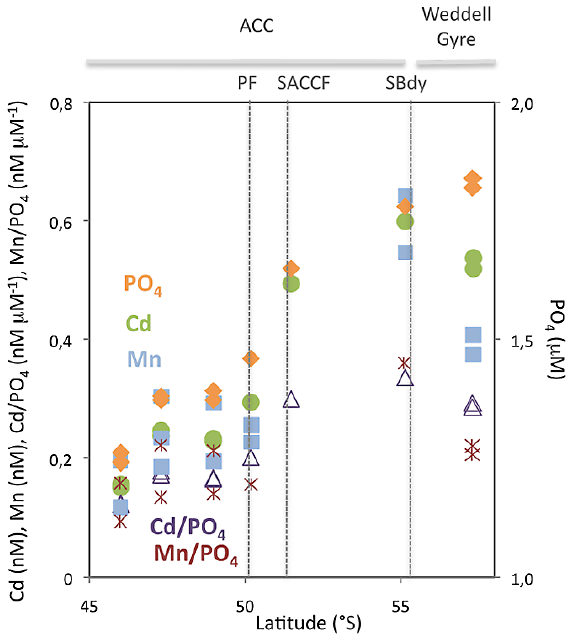
Fig. 8. Variations of Cd (green circles, in nM), Mn (blue squares, in nM) and PO 4 (orange diamonds, in µM) concentrations, and of Cd/PO 4 (purple triangles) and Mn/PO 4 (dark red crosses) ra- tios (in nMgµM − 1 ) as a function of latitude in the surface wa- ters ( > 60m) of the Antarctic Circumpolar Current and the northern Weddell Gyre along the Greenwich